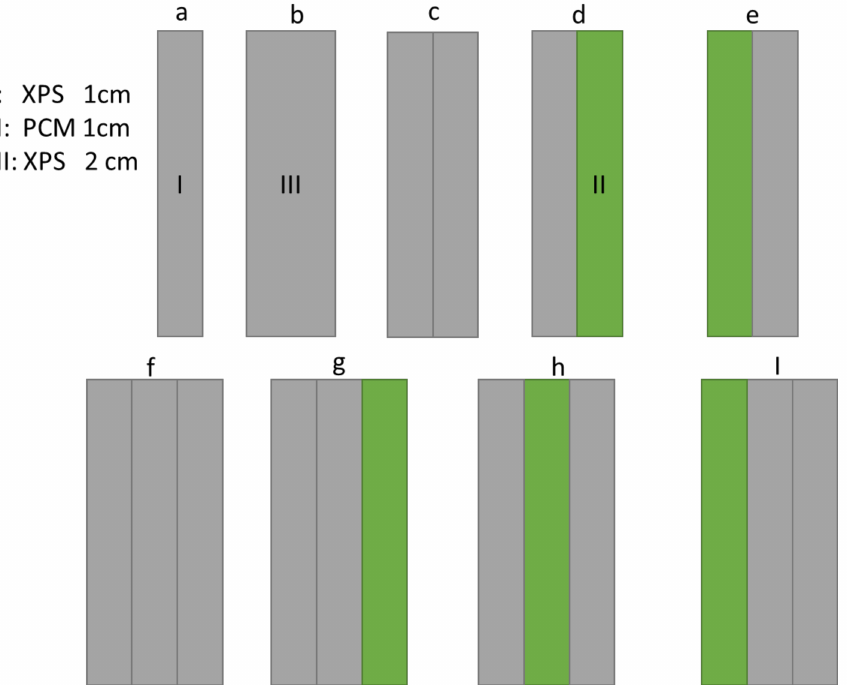
Figure 3. Wall configurations. Note that the wall’s left side is inside the hotbox and the right side is the room. Again, grey stripes stand for XPS; green stripes stand for PCM. a: one layer XPS with thickness of 1 cm; b: one layer XPS with thickness of 2 cm; c: two layer XX; d: two layer XP; e: two layer PX; f: three layer XXX; g: three layer XXP; h: three layer XPX; I: three layer